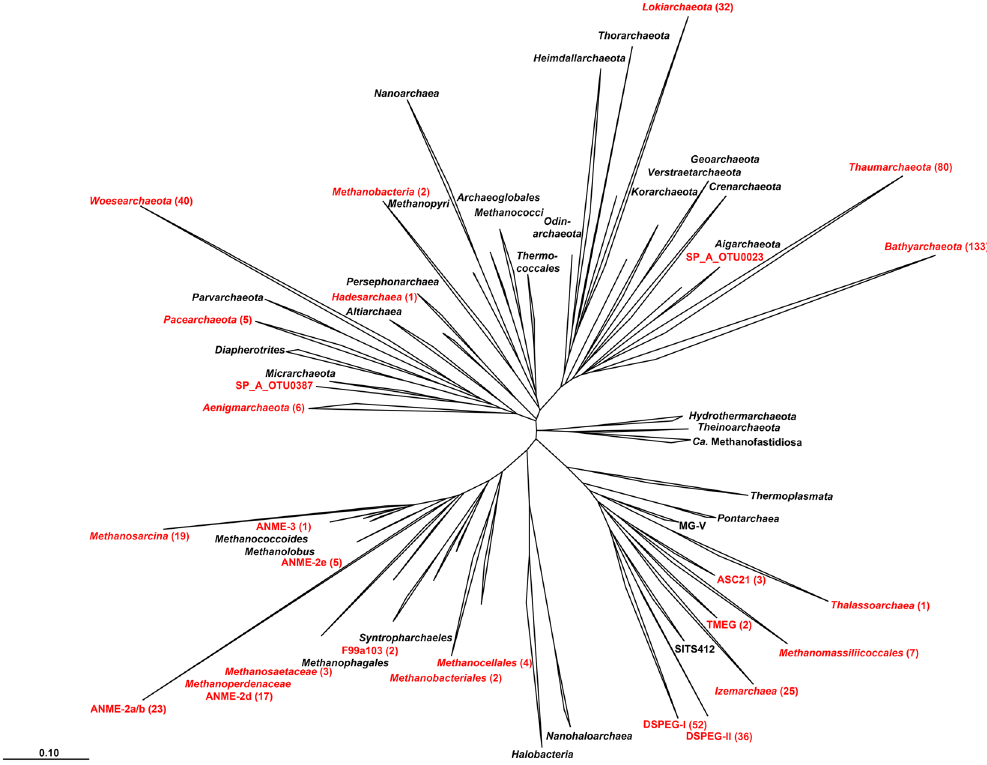
Figure 3. Phylogenetic affiliation of submarine permafrost archaeal sequences based on 16S rRNA gene. Taxonomic cluster in red contain sequences of submarine permafrost. Numbers in brackets show the number of OTUs per cluster. The scale bar represents 10 percent sequence divergence. The tree was rooted with the DPANN superphlyum.